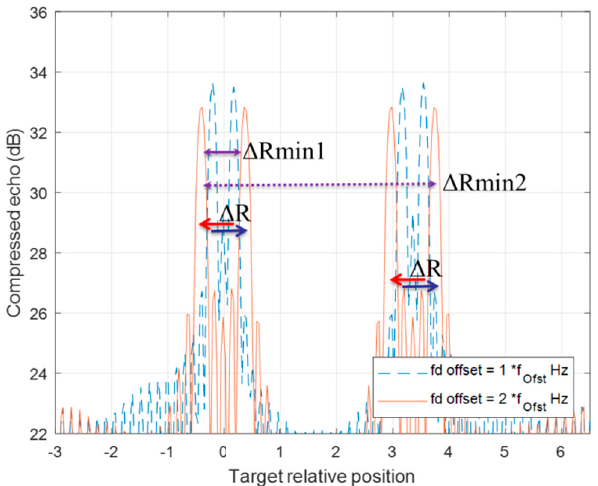
Figure 10. The processing flowchart of one Doppler filter in the multi-Doppler-shift-compensation (MDSC) scheme.